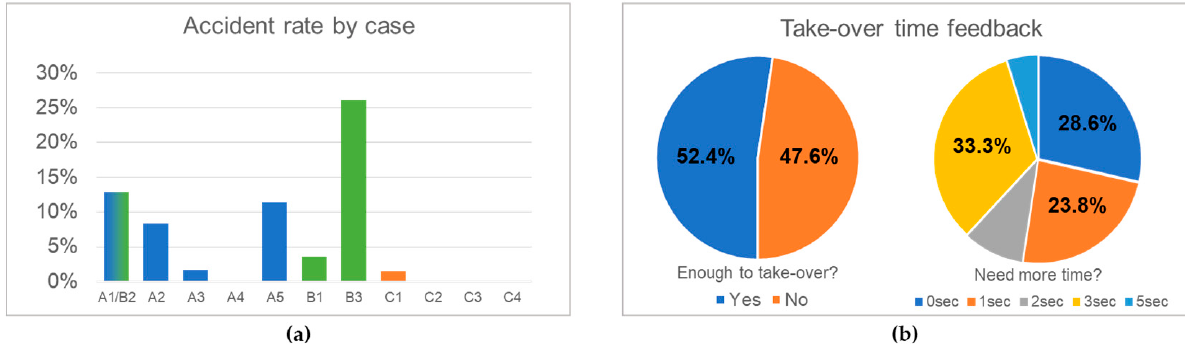
Figure 15. Accident rate and takeover time requirement ( n A 1/ B 2 = 70, n A 2 = 72, n A 3 = 61, n A 4 = 41, n A 5 = 44, n B 1 = 83, n B 3 = 46, n C 1 = 68, n C 2 = 66, n C 3 = 48, n C 4 = 42 ).